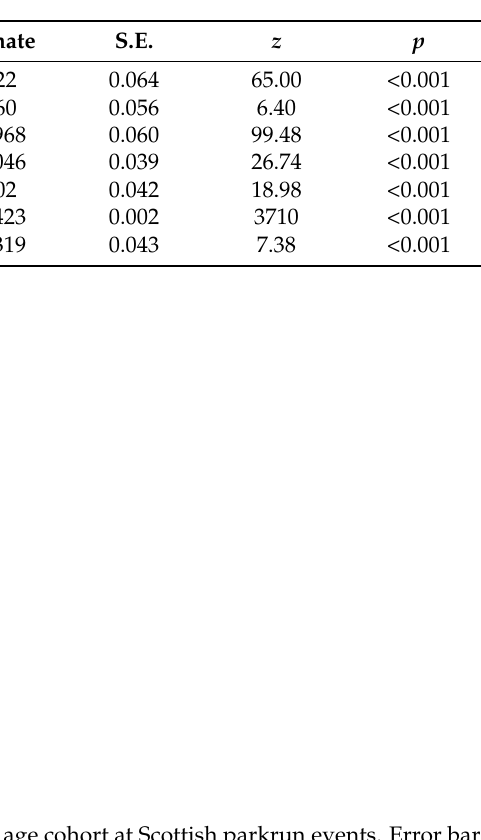
Table 3. A generalised binomial mixed model of the gender of participants at parkrun events in Scotland. Event venue was included as a random effect. Positive parameter estimates are associated with higher numbers of male participants.